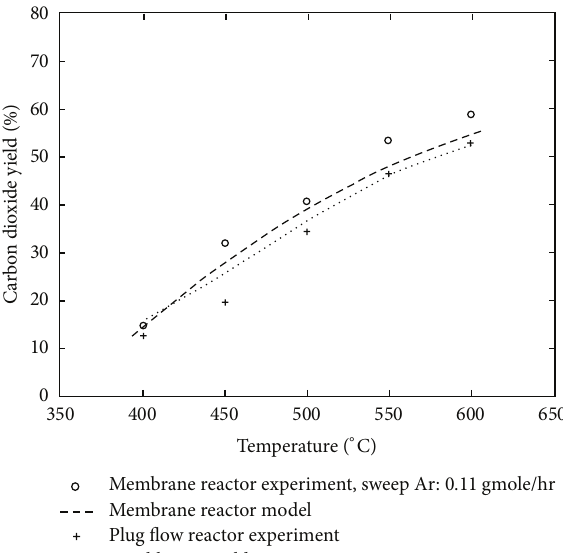
Figure 2: Experimental and modeling results of landfill gas-steam reformers for syngas production and SOFC continuous opera- = 1.68 atm, space time = tion. Carbon dioxide yield data ( 𝑃 𝑇 𝑜 48.0 g cat ⋅ hr/gmole CH4